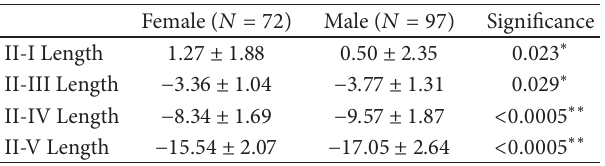
Table 4: Gender differences in metatarsal protrusion. Mean values of metatarsal protrusion expressed in percentage terms related to II ray.